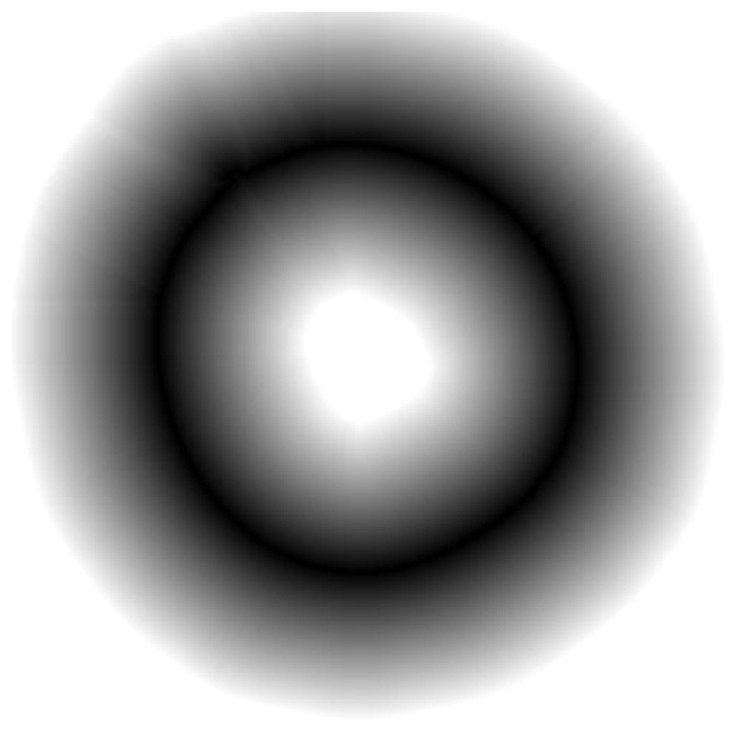
Plant contour from Fig. 3 after distance transformation.Each pixel coordinate holds as its value the Euclidean distance between the pixel itself and the closest pixel of the plant contour. The darker a pixel, the closer it is to the plant contour.